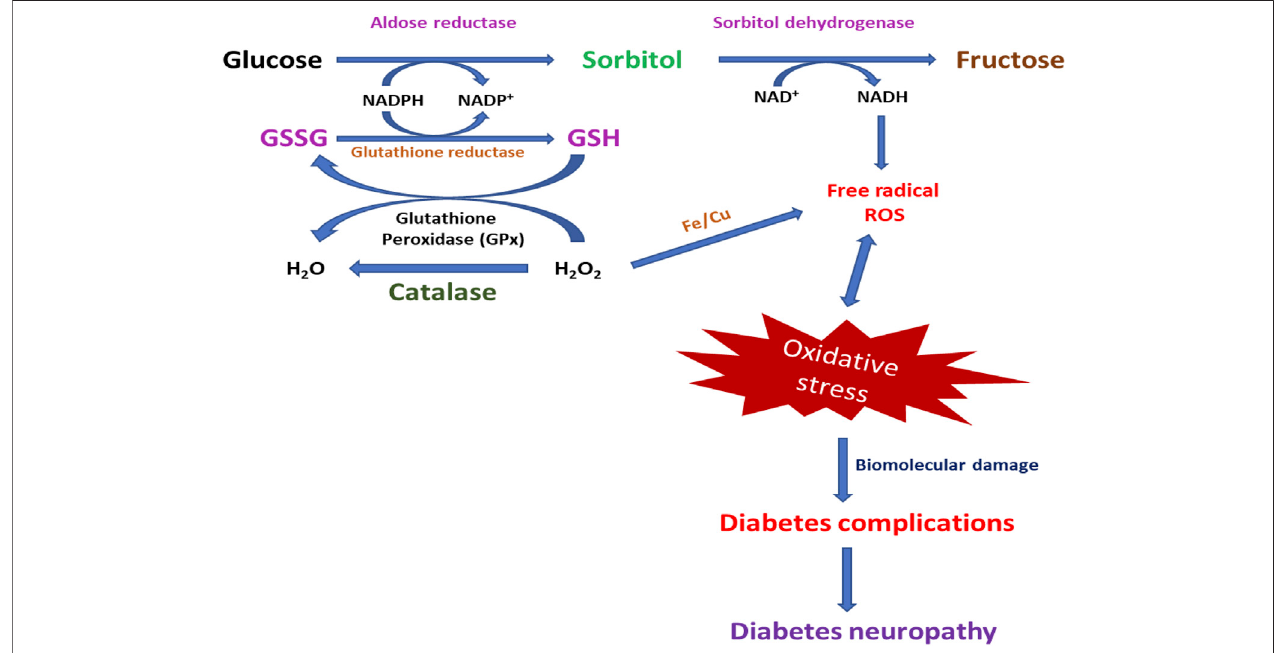
FIGURE 4 | Photographical demonstration of mechanisms of oxidative stress-induced DNP. Oxidative stress-activated pathways for the generation of DNP.